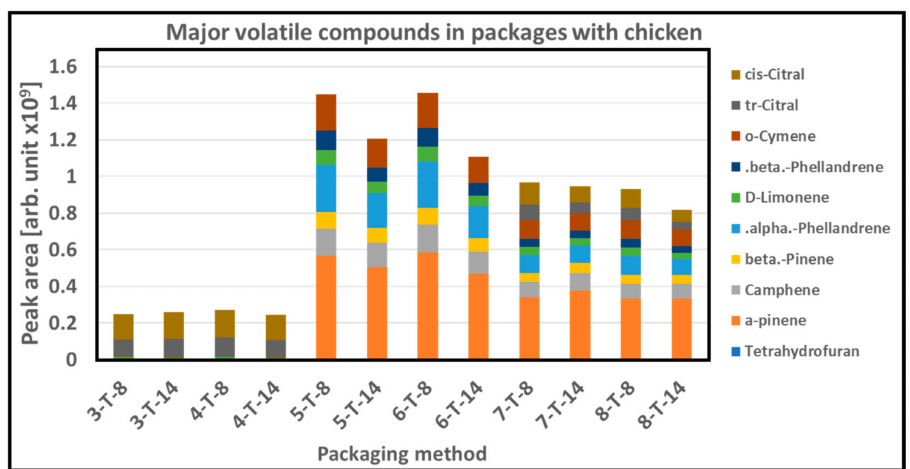
Figure 9. Major volatile compounds in the packaging headspace containing chicken fillets packed with different packaging combinations (PC 3, 4, 5, 6, 7, and 8) after 8 and 14 days of storage. (x-T-y; x = packaging method, y = storage time in days).